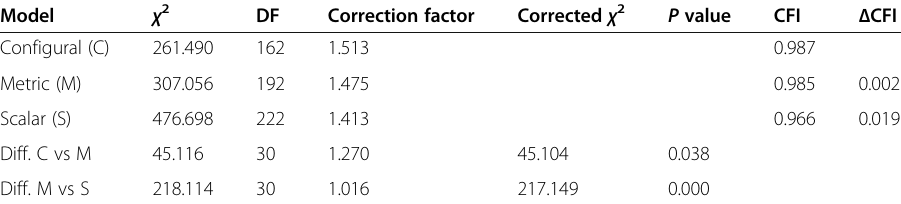
Table 7 Tests of cross-country measurement invariance — agroforestry Model